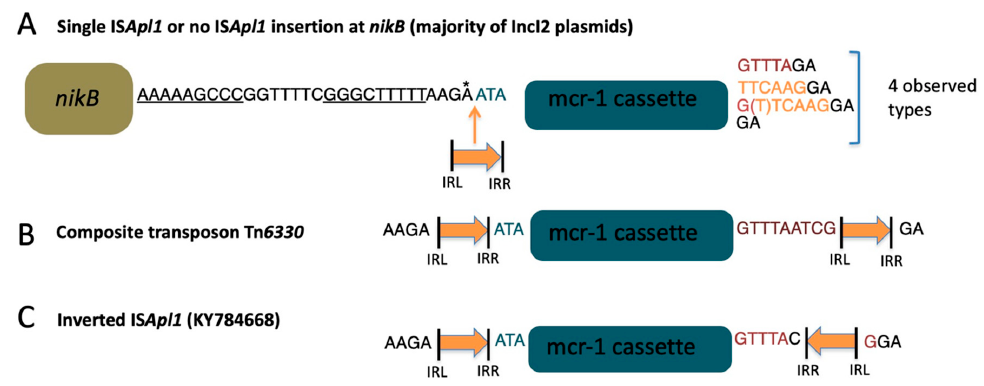
Figure 2. Sequences surrounding the mcr-1 cassette in the IncI2 plasmids characterized in this study. The mcr-1 cassette includes the mcr-1 gene and the PAP-2 hypothetical protein, as well as flanking sequences that are conserved among all the plasmids in this study. IRL and IRR refer to the left and right inverted repeats respectively for IS Apl1 (orange arrow). ( A ) Palindromic sequence (7 bp central core flanked by 9 bp inverted repeats underlined in figure) found downstream of the nikB gene and adjacent to most mcr-1 insertions in IncI2 plasmids. The final ‘A’ in this sequence (denoted with a star) is present in cases with IS Apl1 , and absent when IS Apl1 is absent. The sequences in blue appear to have inserted with the mcr-1 cassette. The upstream sequence in black is present in the IncI2 plasmids without mcr-1 . Downstream of the mcr-1 cassette shows greater variability. The sequences in red correspond with the original sequence from the composite transposon (shown in B), sequences in orange are consistent with the end of the IRR in the composite transposon and may represent a remnant after loss of the downstream IS Apl1 . ( B ) The composite transposon Tn 6330 consists of the mcr-1 cassette flanked by two copies of IS Apl1 . The sequences highlighted in red occur between the end of the mcr-1 cassette and the inverted repeat of the IS Apl1 element located downstream of the cassette (relative to mcr-1 transcription). ( C ) Only one composite transposon has an inverted IS Apl1 at the downstream end, and this inversion appears to have centered around the ‘GTTTA’ sequence between the mcr-1 cassette and the inverted repeat for IS Apl1 .